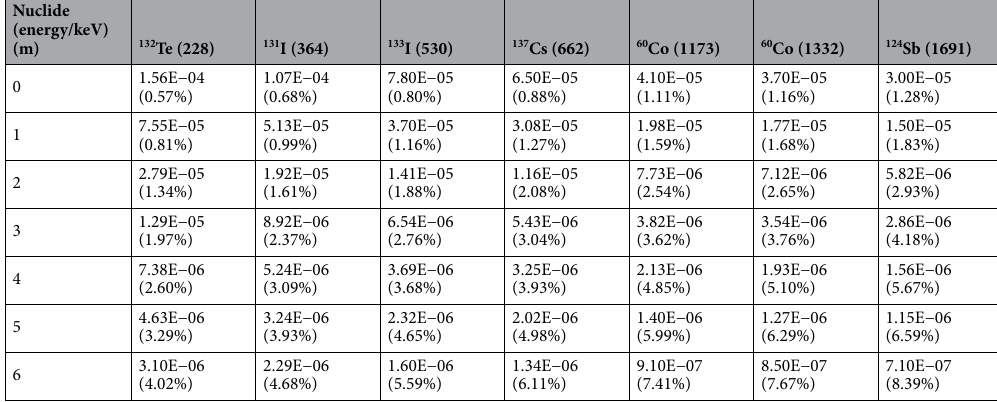
Table 1. Variation of the detection efficiency of different energy γ-ray with horizontal distance.